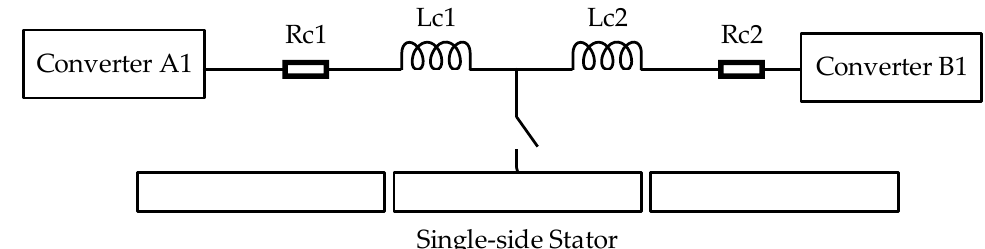
Figure 2. Double-ended power supply model.